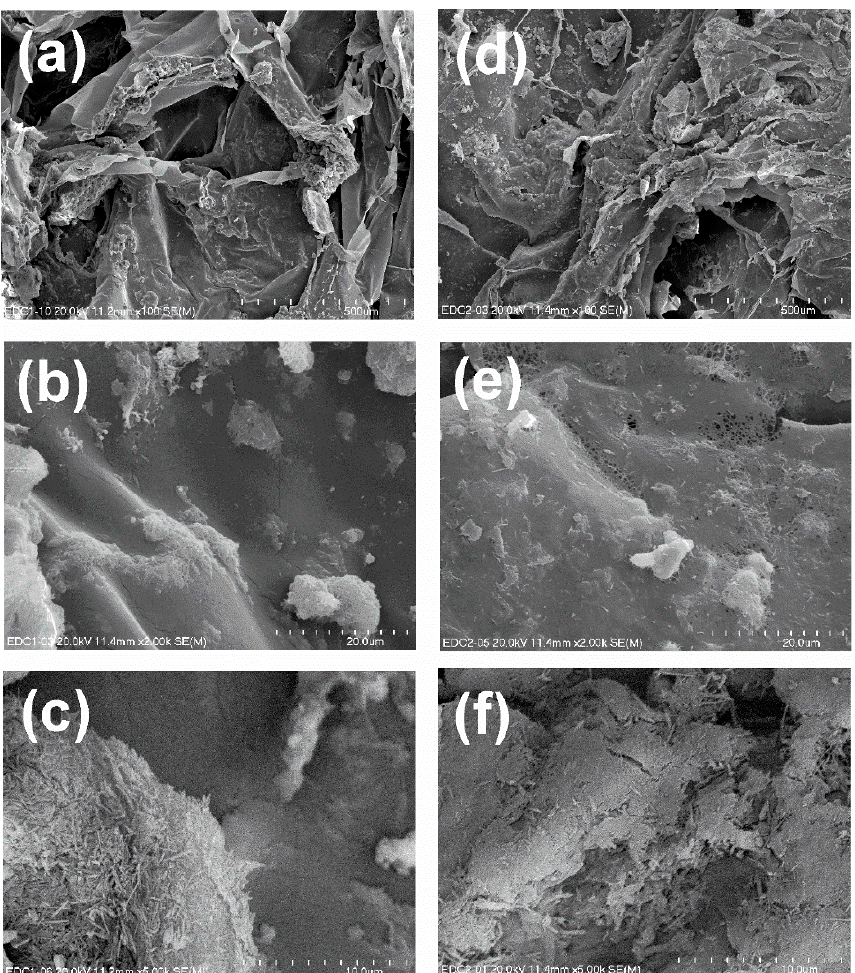
Figure 5. ( a – c ) SEM images obtained for the hydrogel H1-EDC/CaCl 2 ; ( d – f ) SEM images obtained for the hydrogel H2-CaCl 2 /EDC. for the hydrogel H2-CaCl 2